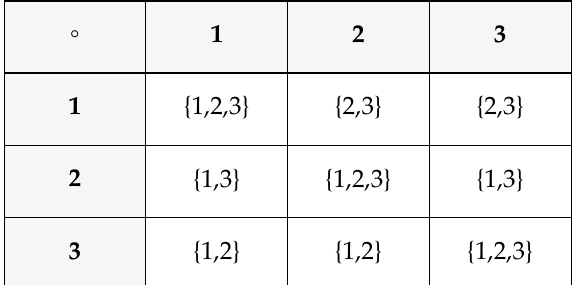
Table 15. The rigid left almost-hypergroup of three elements.